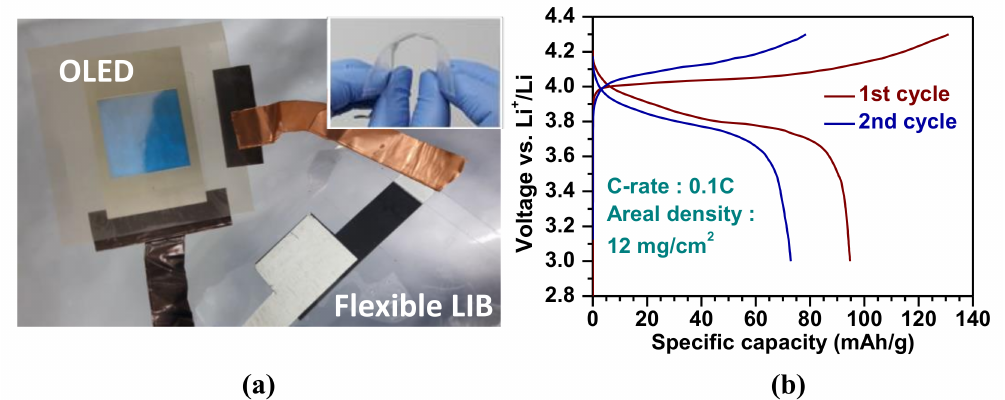
Figure 5. ( a ) A photograph of the assembled flexible LIB cell illuminating a blue OLED under operation at approximately 4 V. The inset image demonstrates the flexible LIB cell under bending condition illustrating the cell’s thinness (<1 mm) and structural flexibility. ( b ) Initial galvanostatic charge and discharge profiles of the flexible LIB cell with the ionic liquid impregnated GPE at 0.1